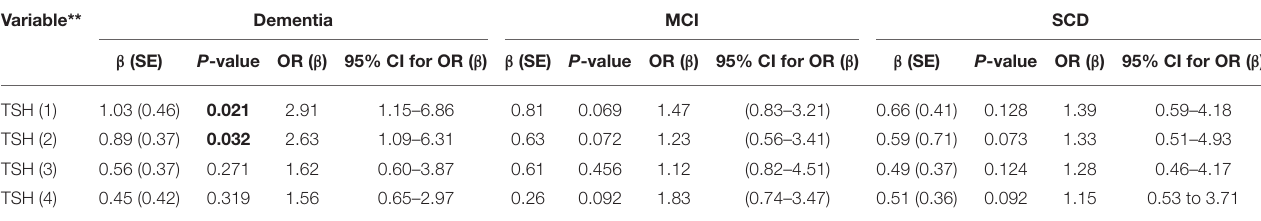
TABLE 4 | Regression analyses * of serum TSH levels (in quintiles) and risk of dementia, mild cognitive impairment, and subjective cognitive decline. Variable** Dementia